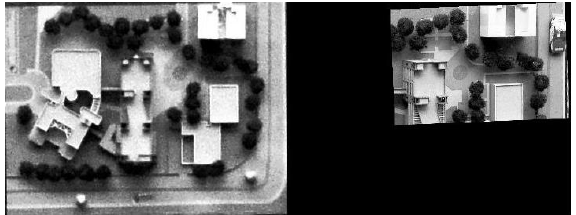
Figure 10. Image registration of two images during